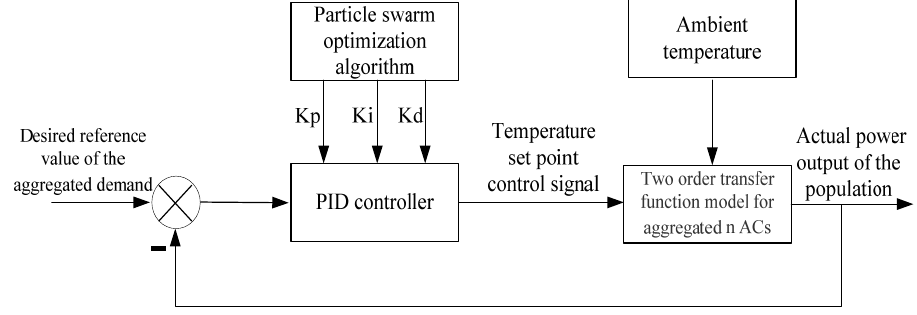
Figure 9. A load control strategy for the AC group based on the particle swarm optimization (PSO) algorithm for Proportional-Integral-Differential (PID) parameter